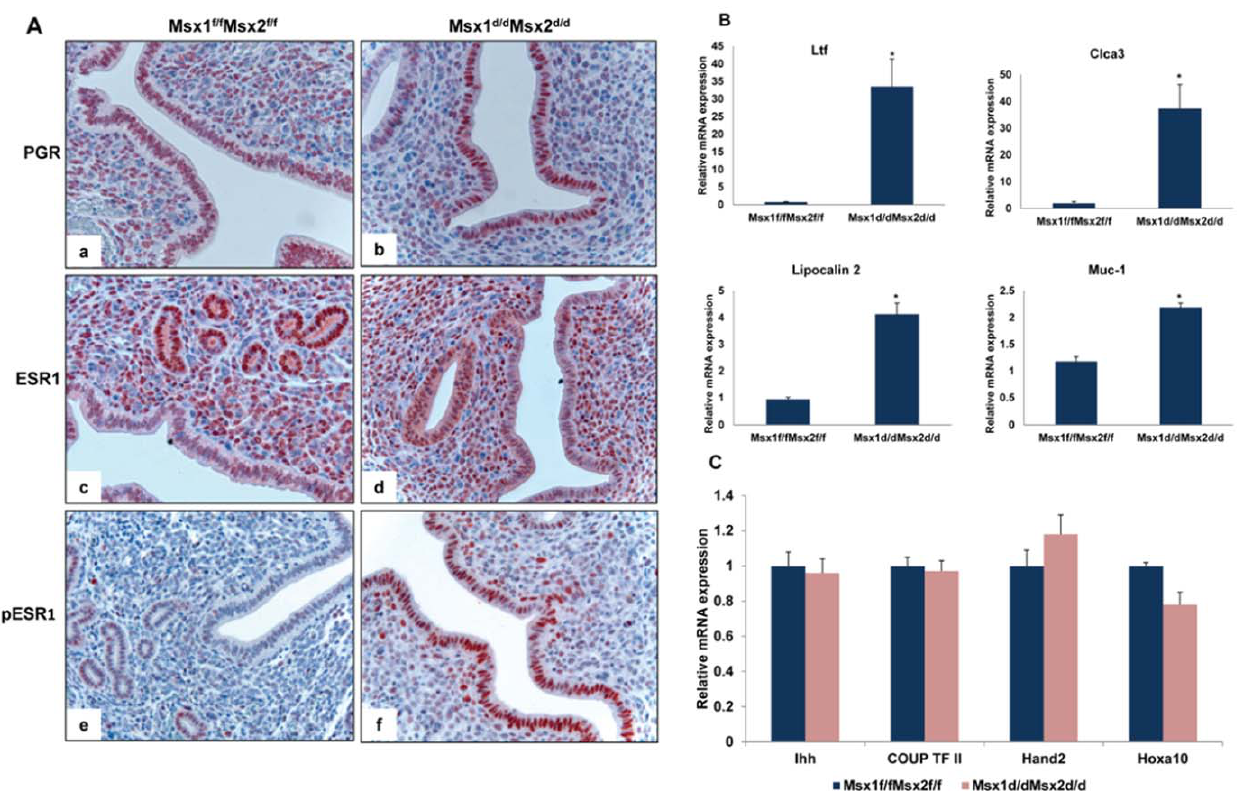
Figure 3. Enhanced ESR1 activity in the luminal epithelium of Msx1 d/d Msx2 d/d uteri. A. Uterine sections obtained from Msx 1 f/f Msx 2 f/f (left panel) and Msx 1 d/d Msx 2 d/d (right panel) mice on day 4 of pregnancy were subjected to IHC using antibodies against PGR (top panel, a and b), ESR1 (middle panel, c and d) and phospho-ESR1 (lower panel, e and f). B. Real-time PCR was performed to analyze the expression of E-regulated genes, lactotransferrin ( Ltf ), Clca3, lipocalin2 and Muc-1 in uteri of Msx 1 f/f Msx 2 f/f and Msx 1 d/d Msx 2 d/d mice on day 4 of pregnancy. The level of Ck18 was used as internal control to normalize gene expression. The data are represented as the mean fold induction 6 SEM, *p , 0.05. C. Real-time PCR was performed to analyze the expression of P-regulated genes, Ihh, COUP-TF II, Hand2 and Hoxa10, in uteri of Msx 1 f/f Msx 2 f/f and Msx1 d/d Msx2 d/d mice on day 4 of pregnancy. The level of Rplp0 or Ck18 was used as internal control to normalize gene expression.